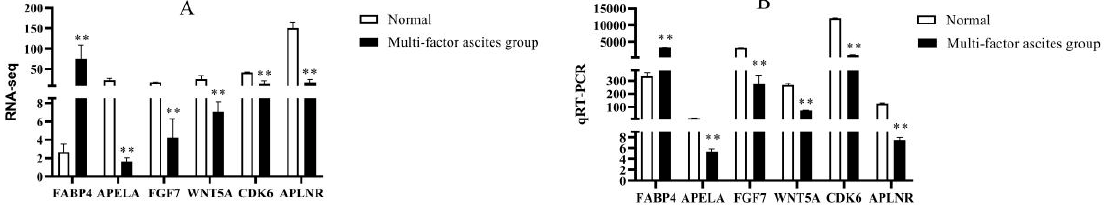
Figure 6. Up-regulated and down-regulated genes were obtained using KEGG enrichment analysis. The x -axis at the bottom indicates the number of genes corresponding to points on the broken line. The x -axis at the top indicates the significance of enrichment corresponding to the bar’s height.